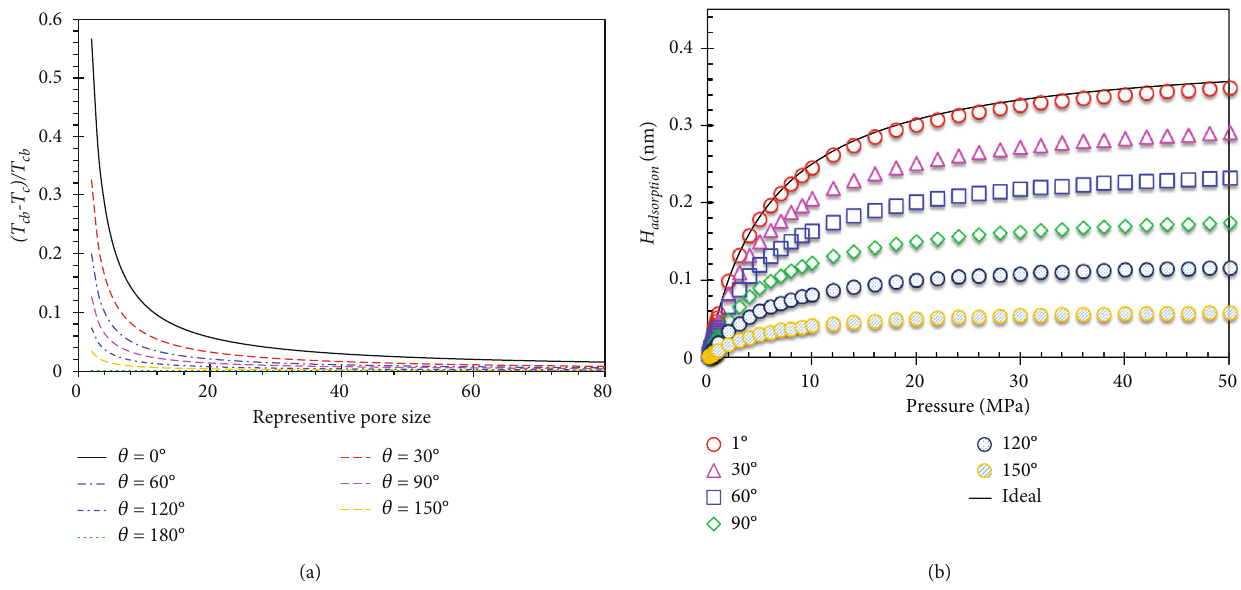
Figure 8: The variation of key parameters caused by wettability impact: (a) Critical properties; (b) Adsorption phase